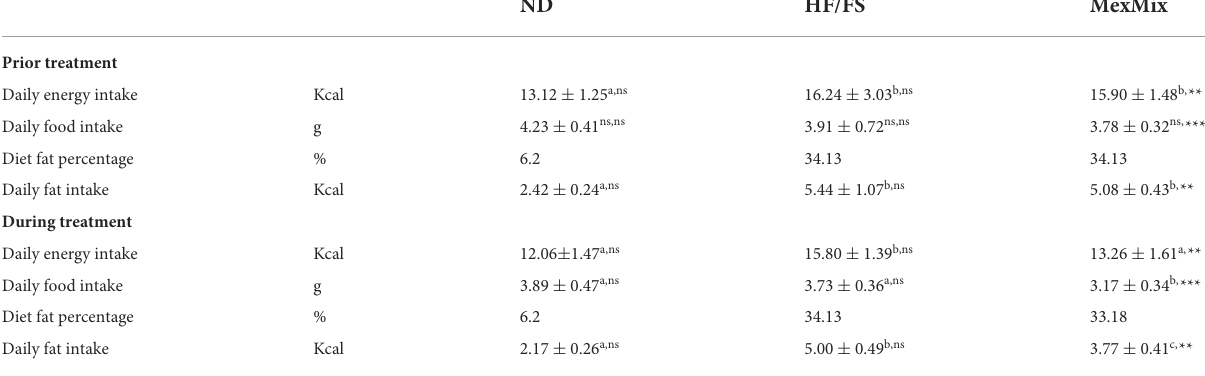
TABLE 1 Dietary intake during experimental phases.